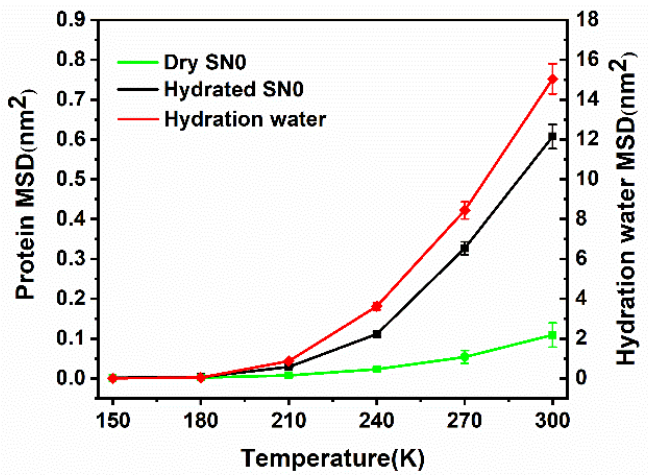
Figure 5. MSD versus temperature. The hydrated SNase is shown in black, the dry SNase in vacuum is shown in green, and the hydration water near the protein is in red. The hydration shell was defined as the water molecules within 0.6 nm of the protein. The MSD was calculated for protein no-H atoms. The 19 ns trajectory was divided into 95 periods. The MSD difference in each period (200 ps) was obtained and the final value was averaged over all periods with standard deviation [45].